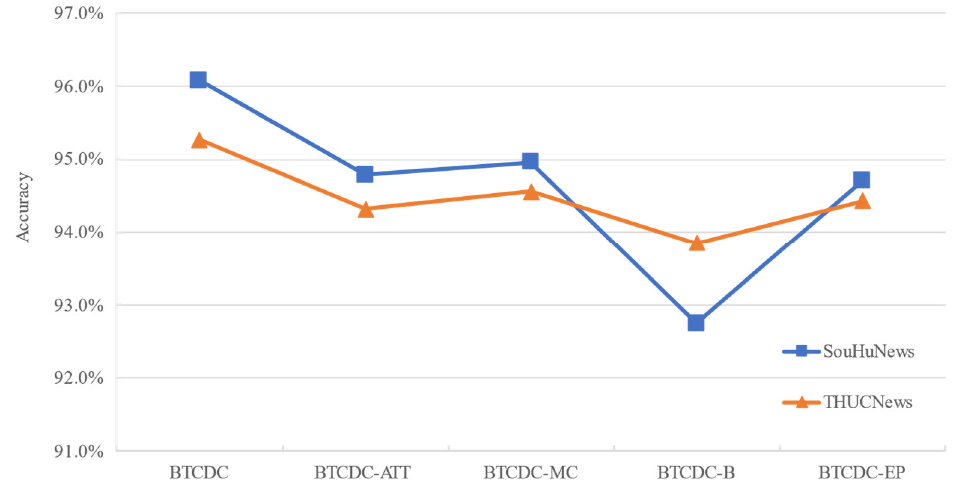
Figure 6. Results of ablation experiments.